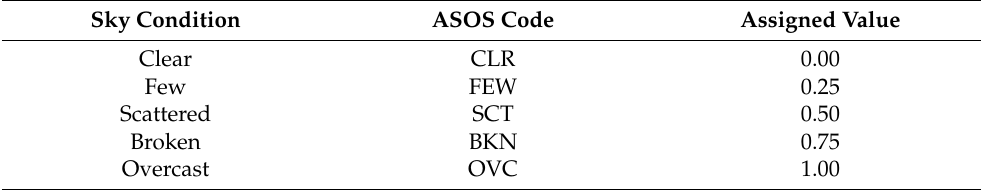
Table 1. The numerical cloud fraction values assigned to the ASOS sky cover values for the ob- served analysis.